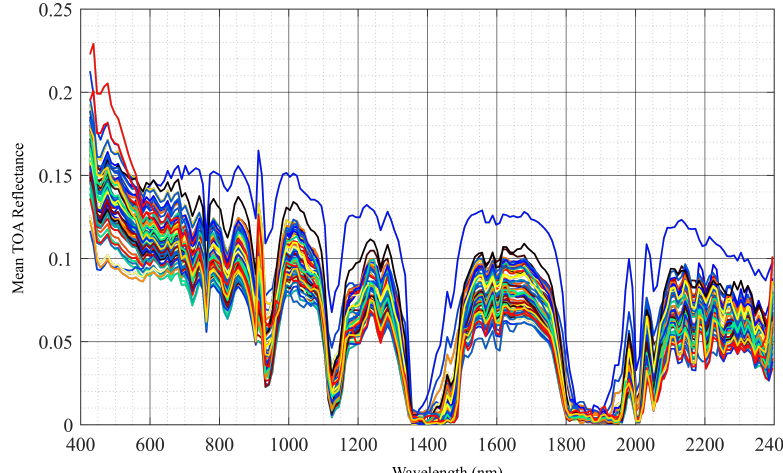
Figure 6. EO-1 Hyperion hyperspectral TOA reflectance for 64 images obtained from the selected stable dark sites.